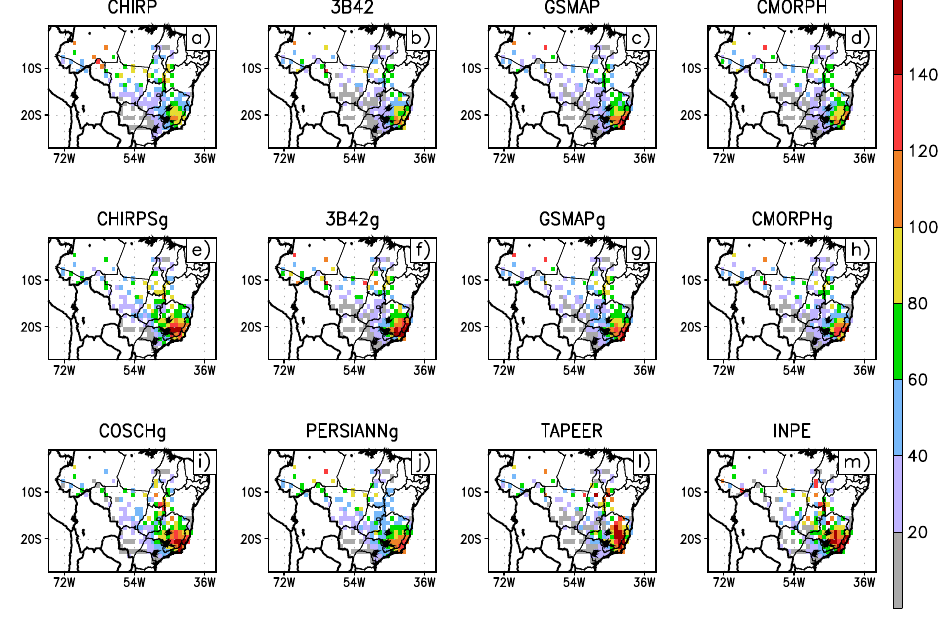
Figure 9. Case of extreme precipitation that occurred over the central region of Brazil (R2) during 1 January 2012 to 5 January 2012 estimated by different products ( a – m